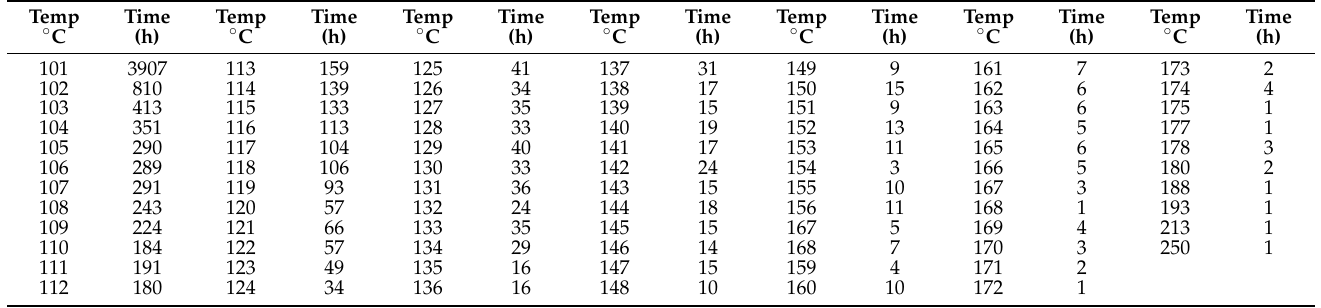
Table 6. Exposure time according to the frequency of conductor temperatures for crisp dynamic rating over a twenty-year period. Temp °C